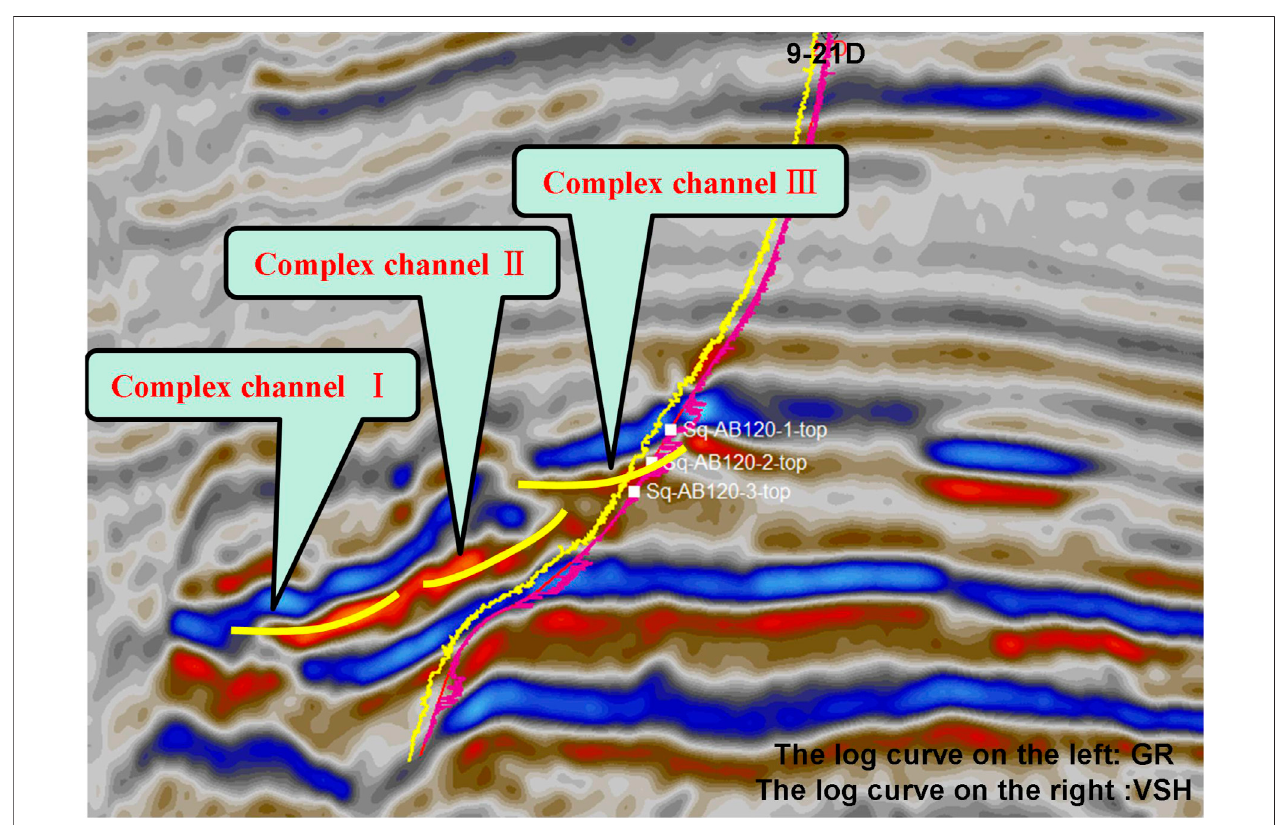
FIGURE 18 | Seismic section of the AB120 reservoir perpendicular to the source direction and through well 9 – 21D.